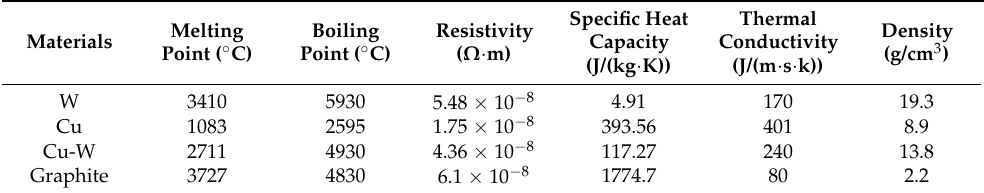
Table 1. Comparison of physical properties of Cu, W, Cu-W and graphite electrodes.